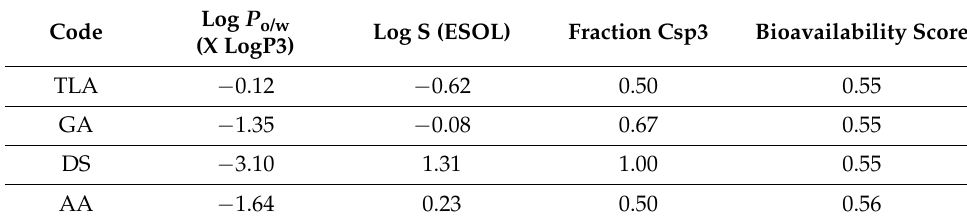
Table 2. Oral bioavailability properties of TLA, GA, DS, and AA.